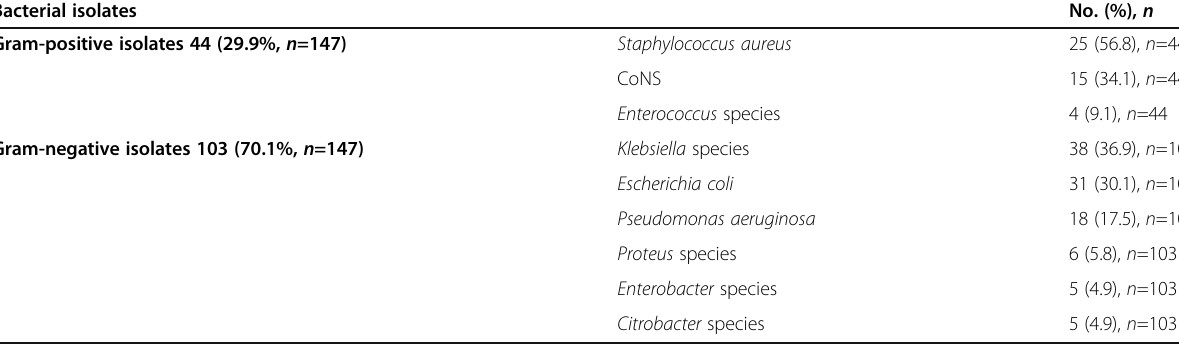
Table 4 Bacterial pathogens from patients with SSI Bacterial isolates